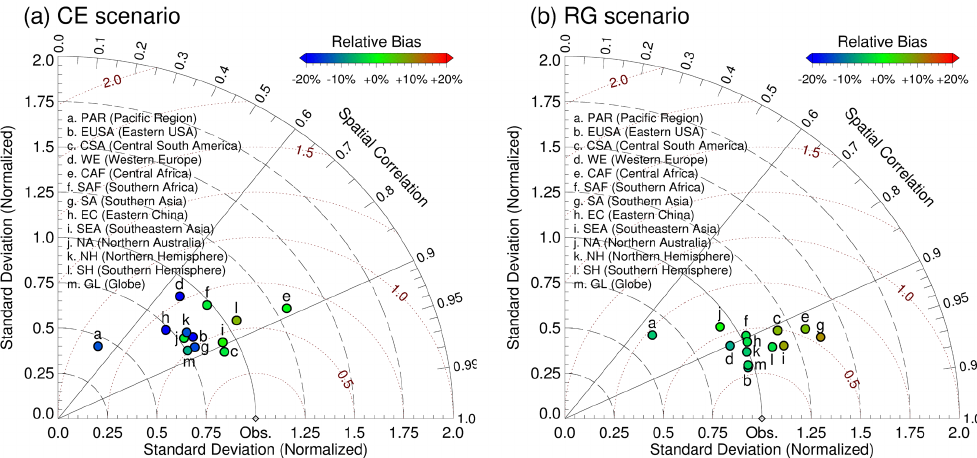
Figure 4. Spatial pattern analyses of the pseudo-retrievals of EMAC simulations based on (a) CE and (b) RG scenarios against MOPITT- retrieved surface CO for selected region domains listed in Table 1. The diagrams show the spatial correlation coefficients, normalized standard deviations, and normalized centered root-mean-square differences between the EMAC simulations and MOPITT observations. The standard deviation and centered root-mean-square difference are normalized to the variances of the observations. Detailed statistical quantities are summarized in Table